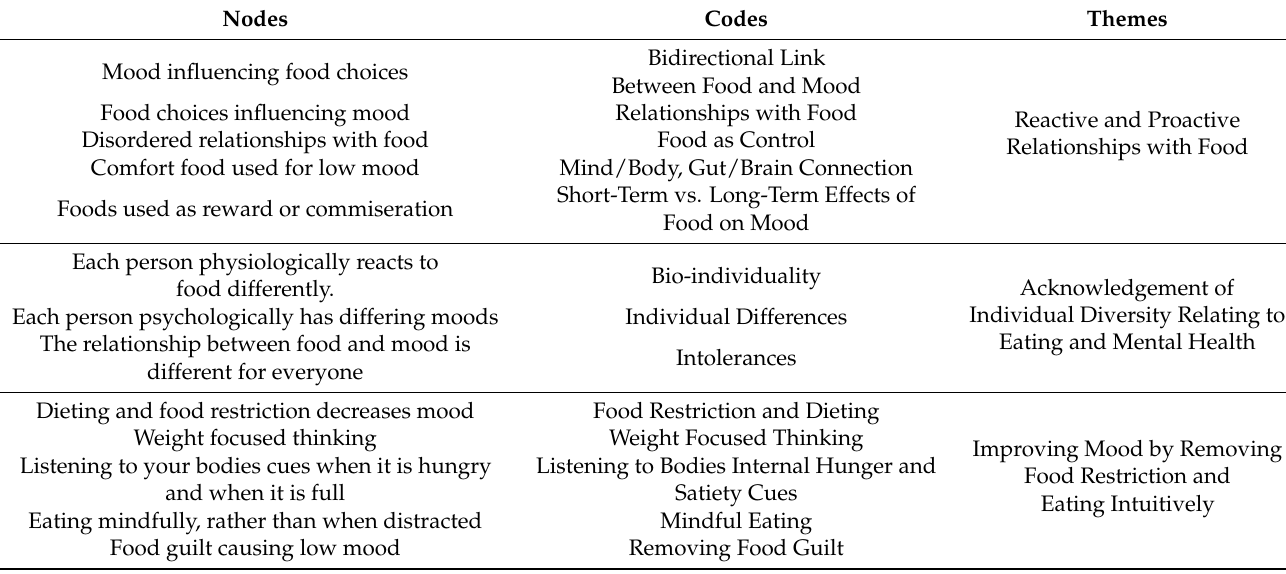
Table 1. Thematic template analysis